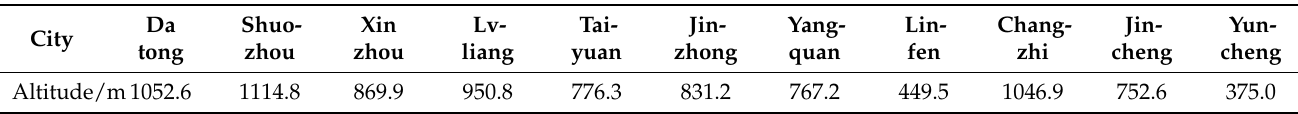
Table 1. Altitudes of the 11 main cities in Shanxi Province (which refer to the meteorological observation stations in the urban areas).